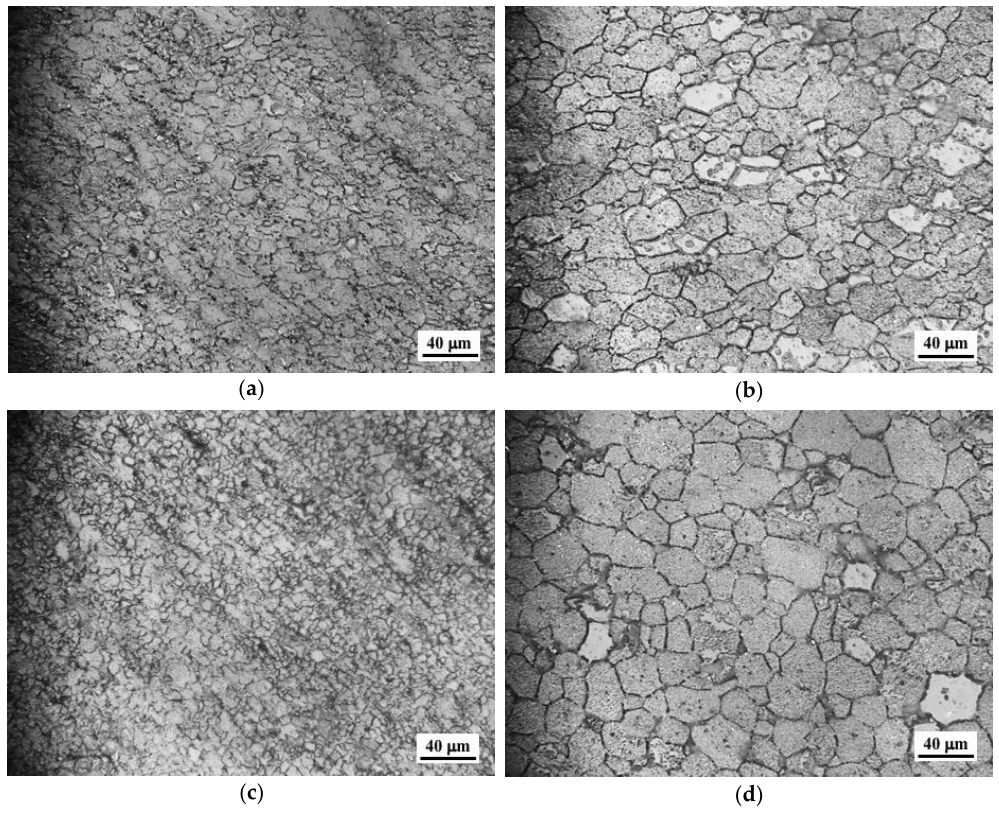
Figure 6. Microstructures obtained on extruded ABaX422 alloy specimens compressed under peak efficiency conditions in the four different domains of the processing map. ( a ) Domain 1 (380 °C/0.0003